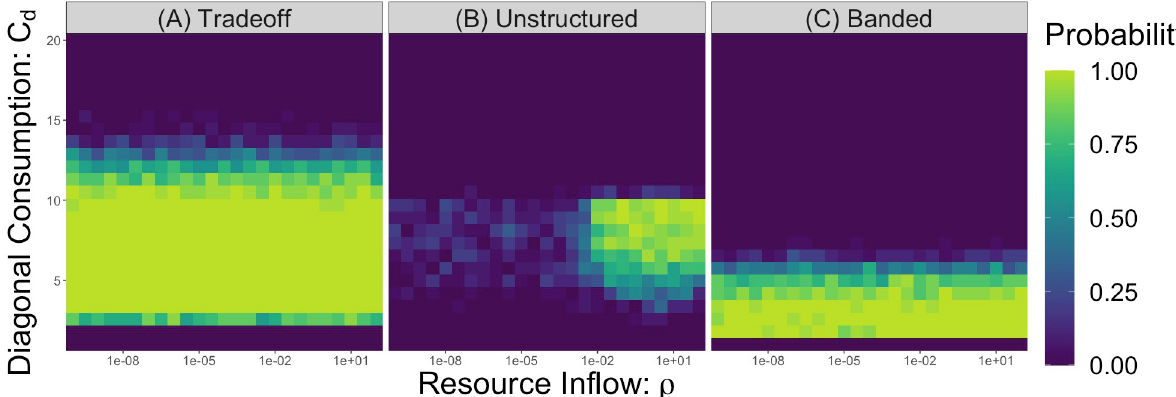
Fig 5. Low consumer abundances induce instability for more general resource inflows and interaction networks. We plot the probability of values and resource inflows ρ with only one externally supplied nutrient finding a feasible and stable fixed point in 25 replicates across a range of C d for three different matrix parameterizations. We also enforce that the fixed point is realized under a Liebig’s law growth rule, where each consumer grows on the most limiting nutrient of the resources. (A) The tradeoff matrix parameterization does not show any dependence on the resource inflow ρ , as in Fig 4. (B) The unstructured case does not have any feasible and stable fixed points at low resource inflow. (C) The banded matrix parameterization has a consumption matrix with non-zero values on the upper and lower bands of the matrix, displaced from the diagonal by one index. It also has a constant production matrix, as described previously. It does not show any dependence on the resource inflow. Parameters: S = 15, η i = 1, θ = 0.9, � ii = 0.05 and � ij = 1 for i 6¼ j . Consumption coefficients sampled from uniform distributions on [0.5, 1.5] before the constraints are